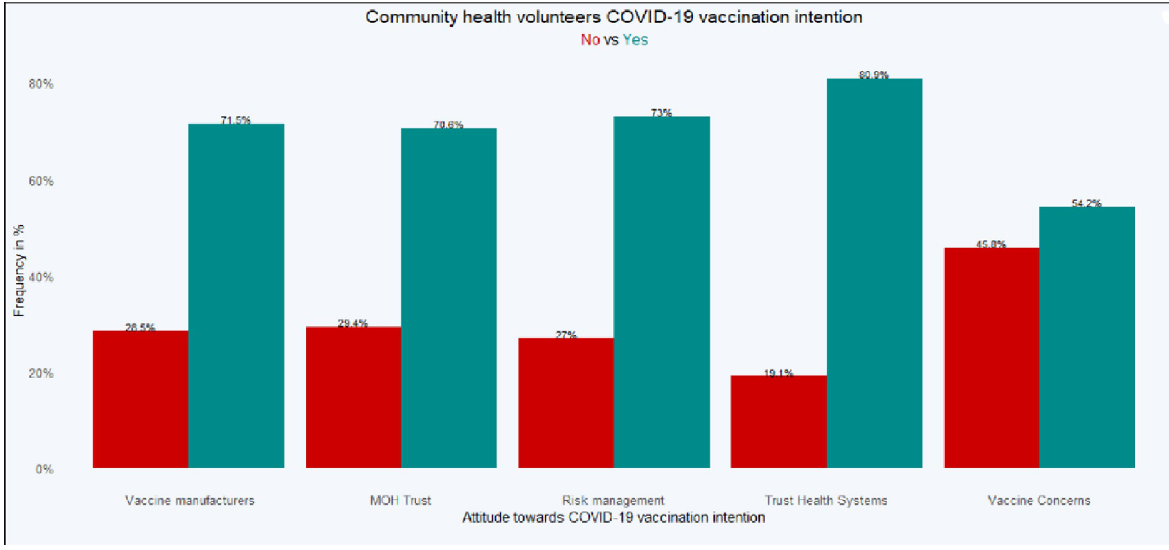
Fig 1. COVID-19 vaccination intention among community health volunteers.